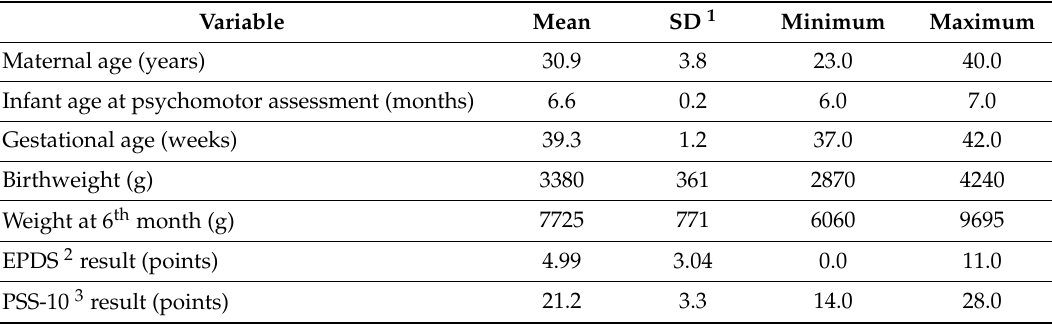
Table 1. The study group characteristics: continuation